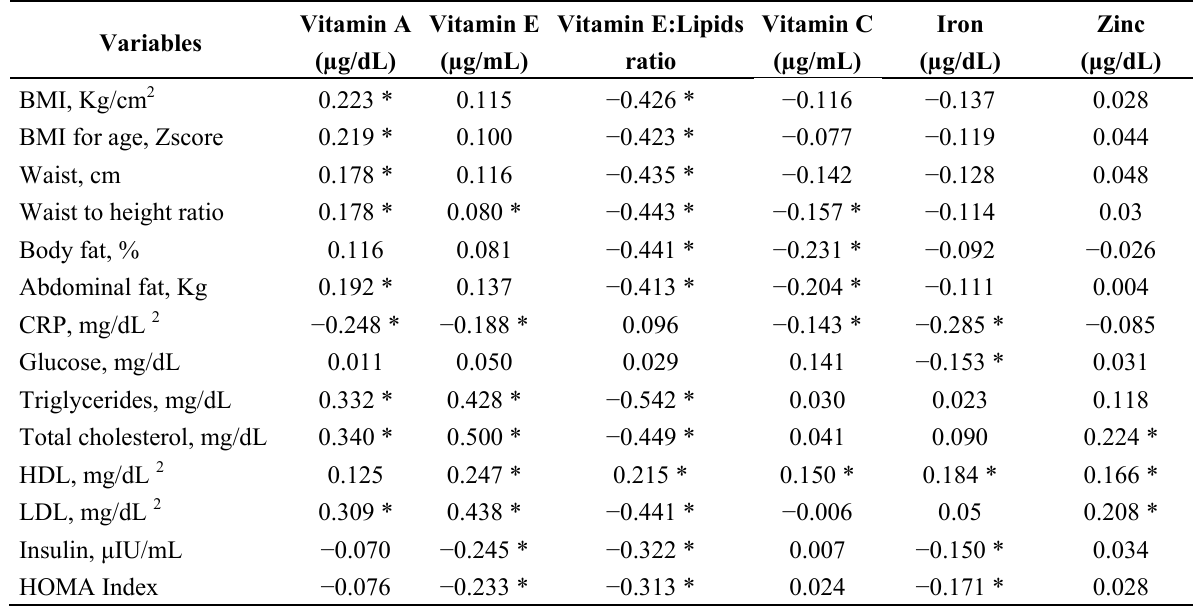
Table 4. Adjusted correlations between micronutrients and anthropometry, body composition and biochemical variables in school-aged children from rural Mexico ( n = 197) 1